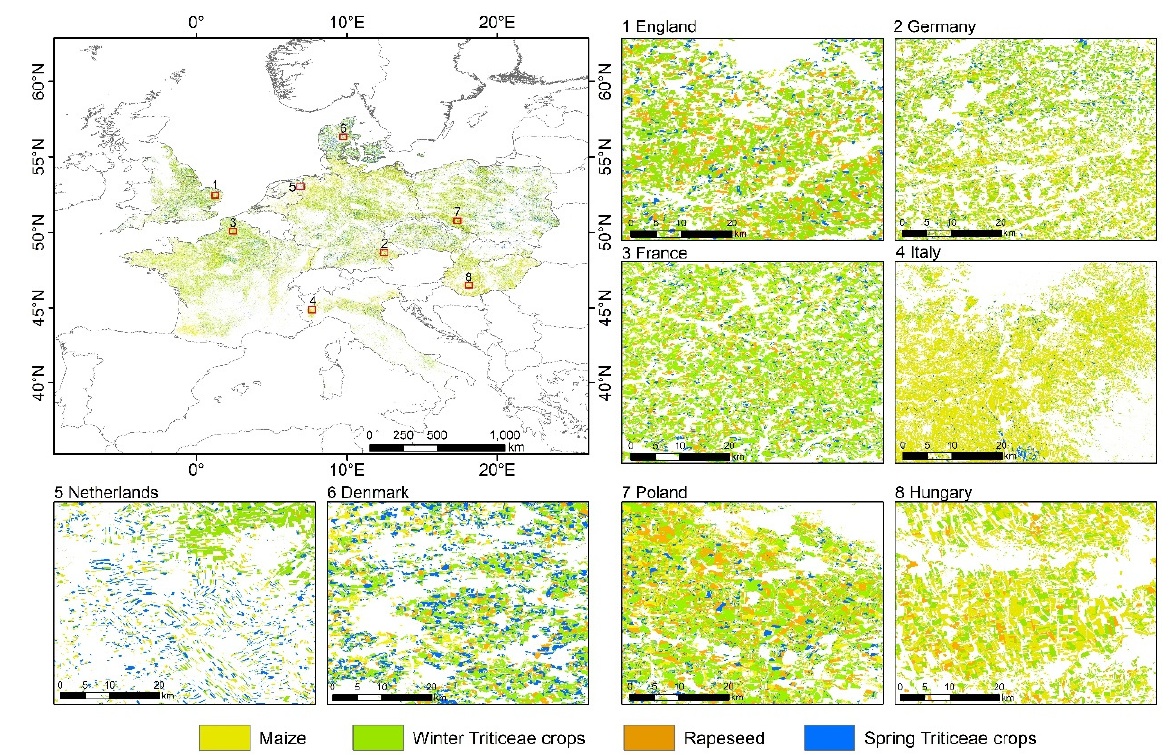
Figure 6. Crop maps at 10 m resolution for 8 of the 10 EU countries in 2019.